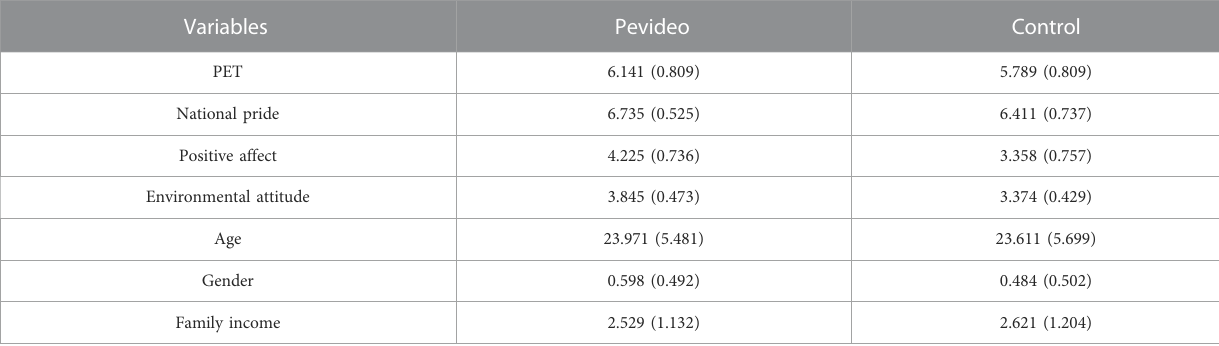
TABLE 3 Descriptive statistics in Study 3.